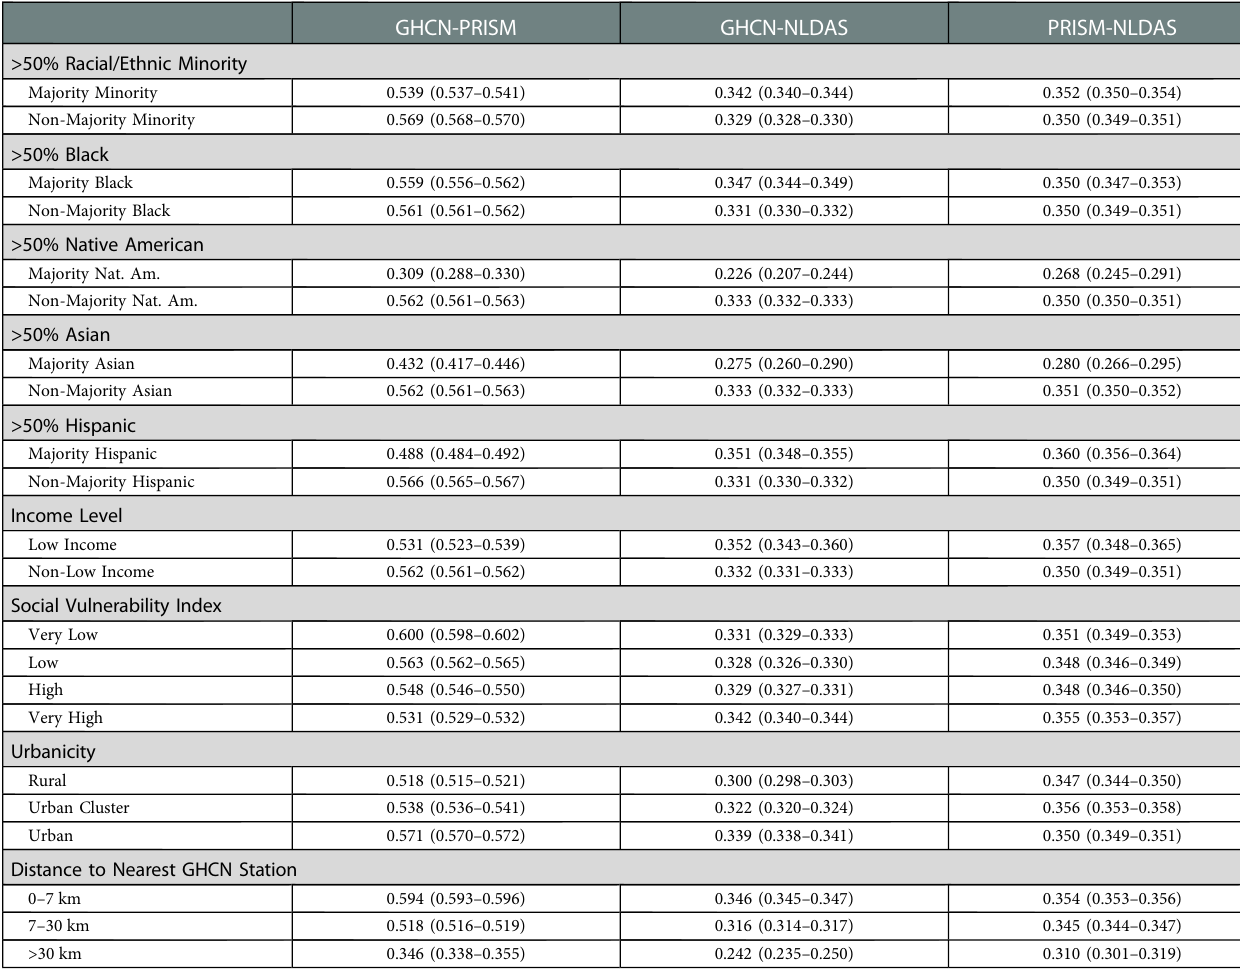
TABLE 2 Census tract population effects on agreement of EPE (>99th percentile) identi fi cation (2011 – 2020).